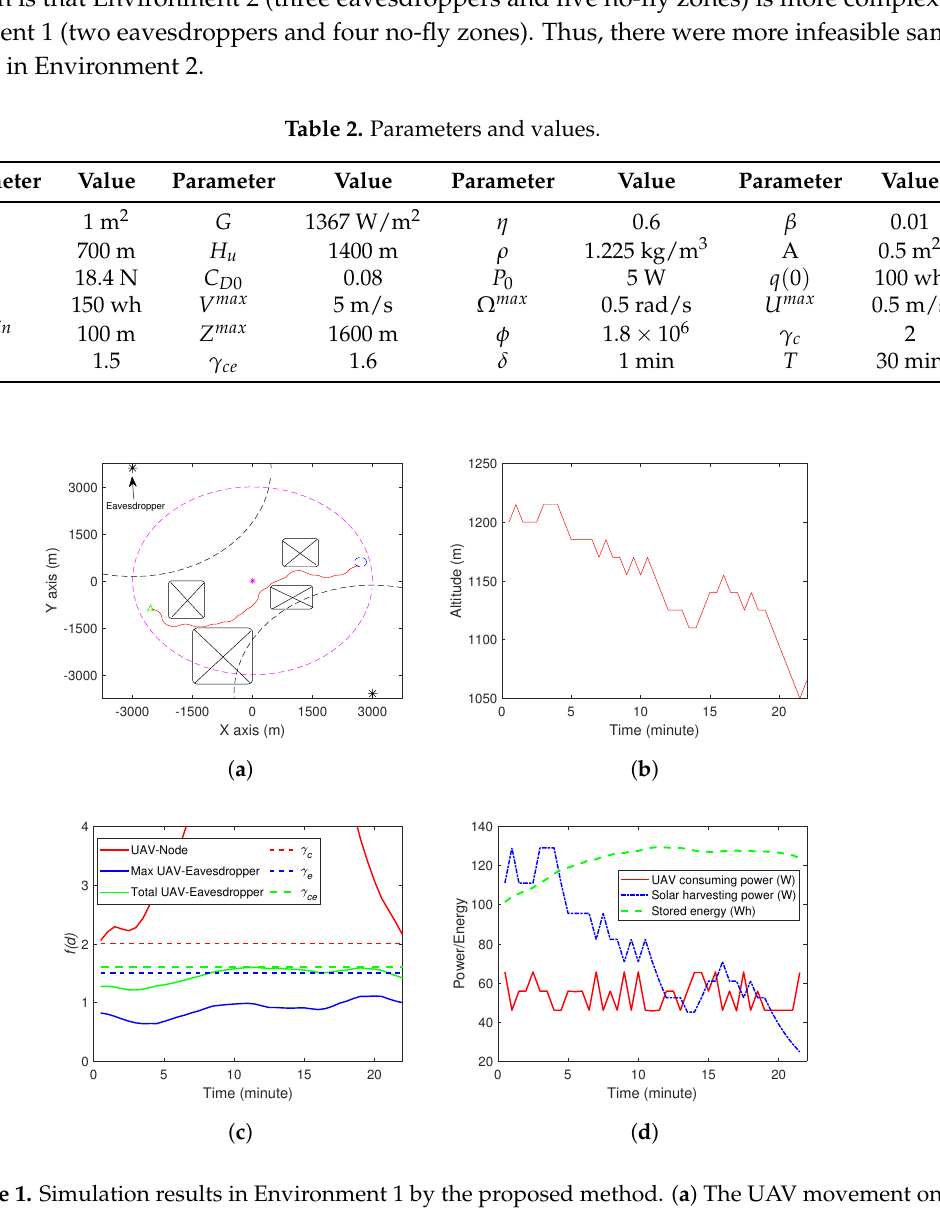
Figure 1. Simulation results in Environment 1 by the proposed method. ( a ) The UAV movement on x-y plane. A video is available: https://youtu.be/7EpmQZuOwao. ( b ) The UAV altitude. ( c ) The communication and eavesdropping performance. ( d ) Energy consumption and solar energy